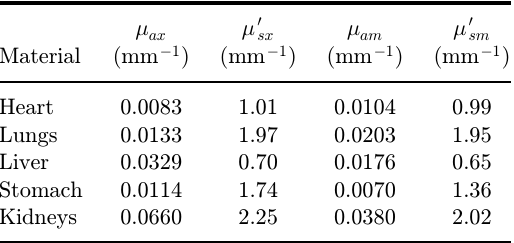
Table 1. Optical properties for the main organs region of 3D mouse